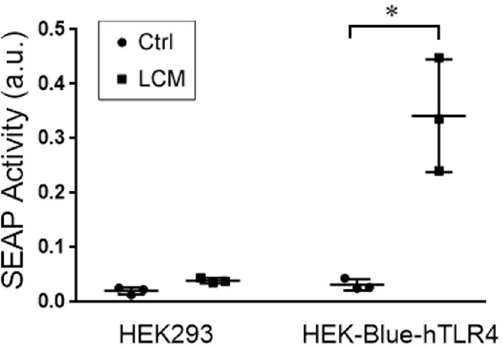
Figure 2. LLC cell-conditioned medium activates TLR4 in reporter cells. TLR4 reporter cell line HEK-Blue hTLR4 (InvivoGen) was treated with LCM or control medium for 24 h and TLR4 activation was measured as the enzymatic activity of secreted embryonic alkaline phosphatase (SEAP) in arbitrary unit (a.u.). Data was analyzed by Student t test. * Denotes a difference ( P < 0.05).